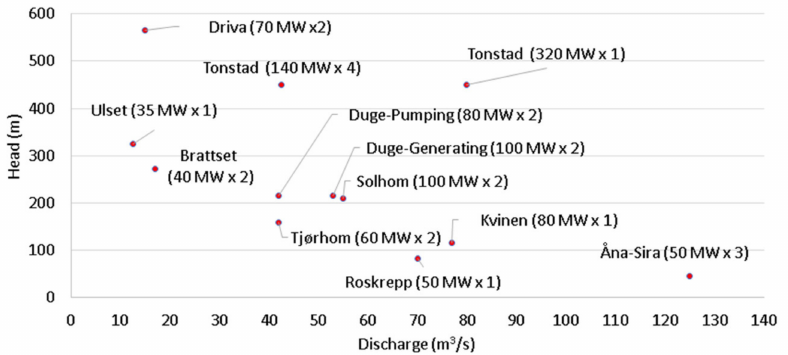
Figure 1. Details of power plant units in the data